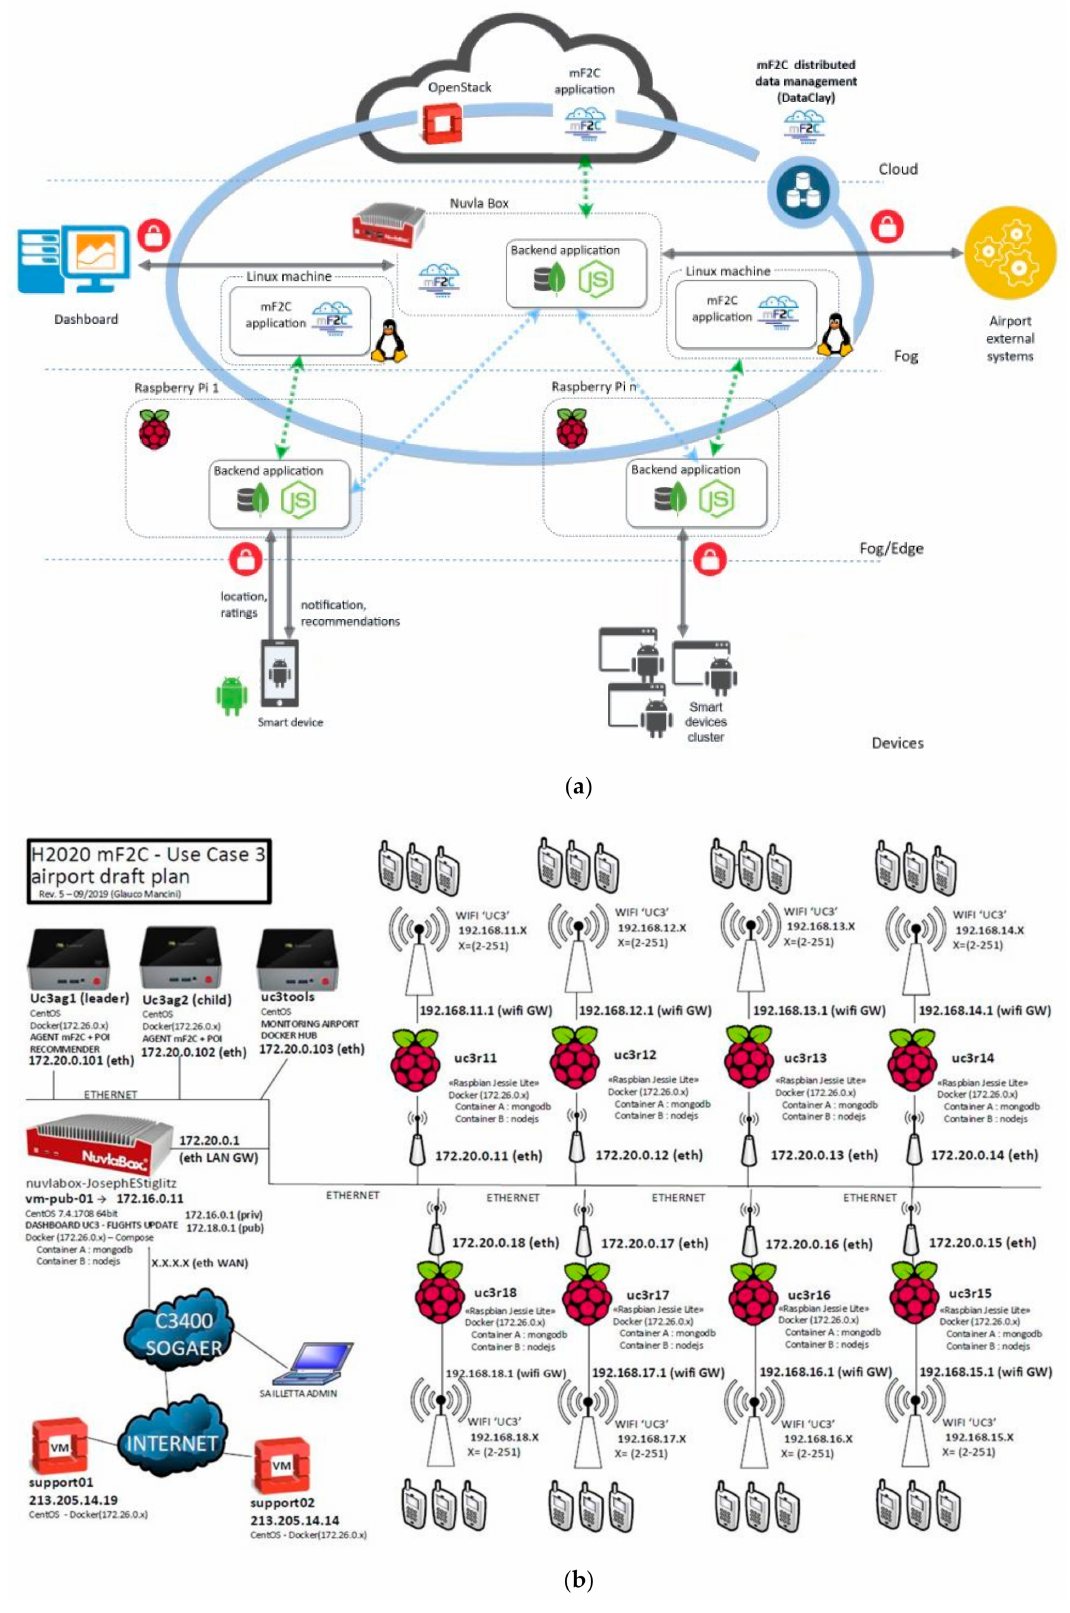
Figure 4. mF2C deployed at the SBS use case: ( a ) SFHS architecture; ( b ) Final systems